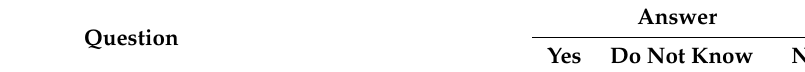
Table A1. Health Self-Assessment